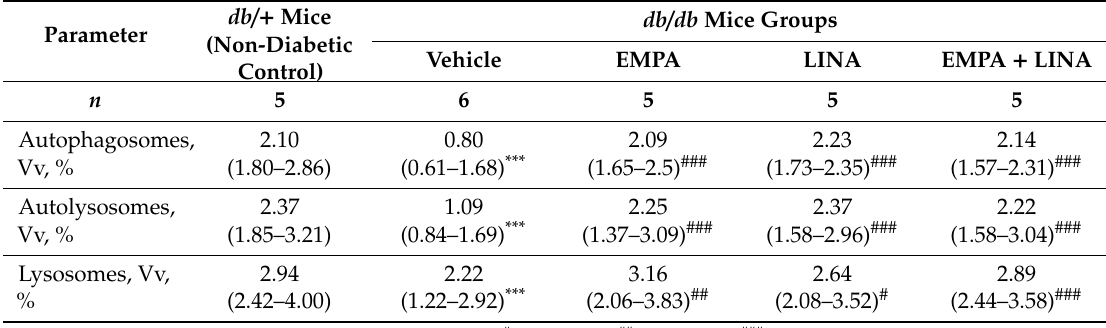
Table 5. The volume density (Vv) of autophagosomes, autolysosomes and lysosomes in podocytes in db /+ and db / db mice.